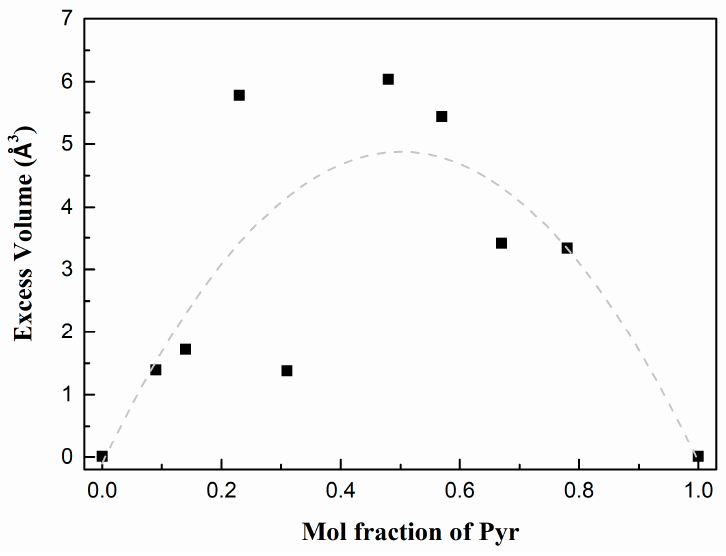
Figure 7. The excess volume versus the pyrope mol.%. Dashed lines (gray) is the polynomial fit to data.